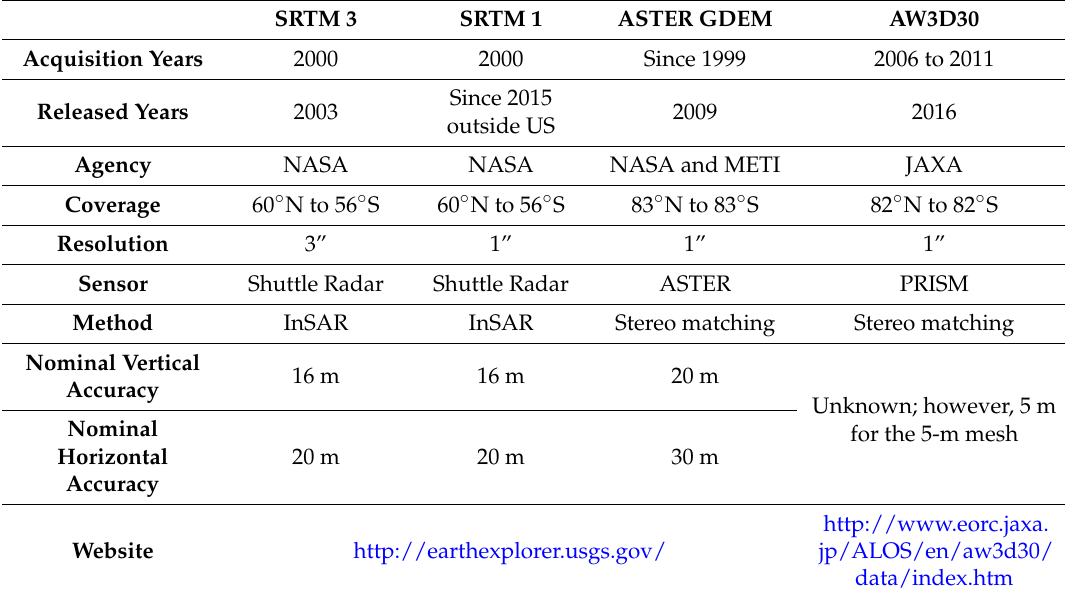
Table 1. Specifications of SRTM 3, SRTM 1, ASTER GDEM and